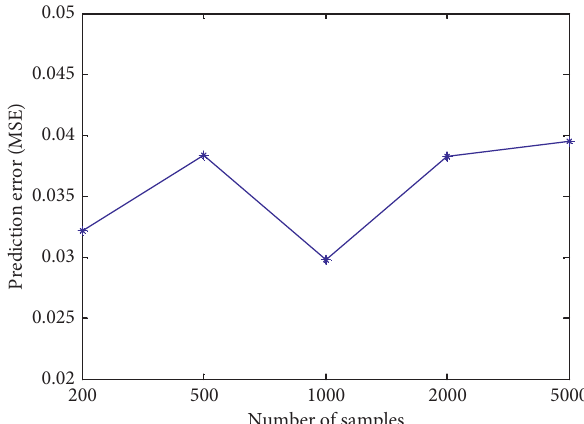
Figure 6: Prediction error (MSE) and sample